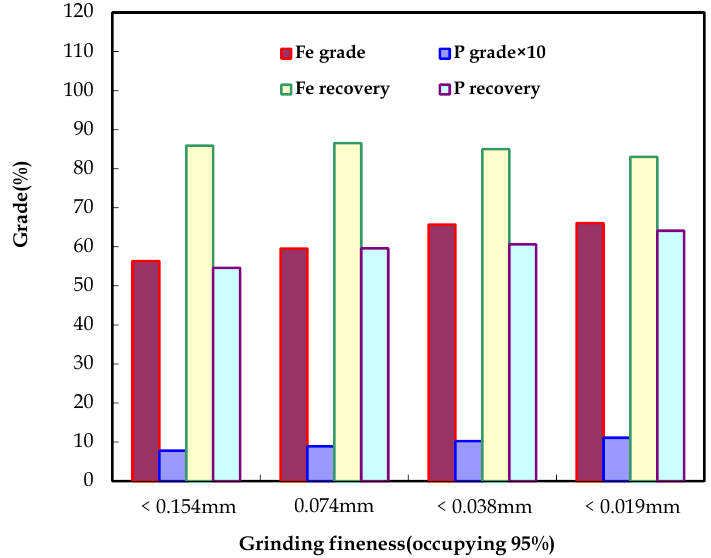
Figure 2. E ff ect of particles size on performance of the low-intensity magnetic Figure 2. Effect of particles size on performance of the low-intensity magnetic separation.